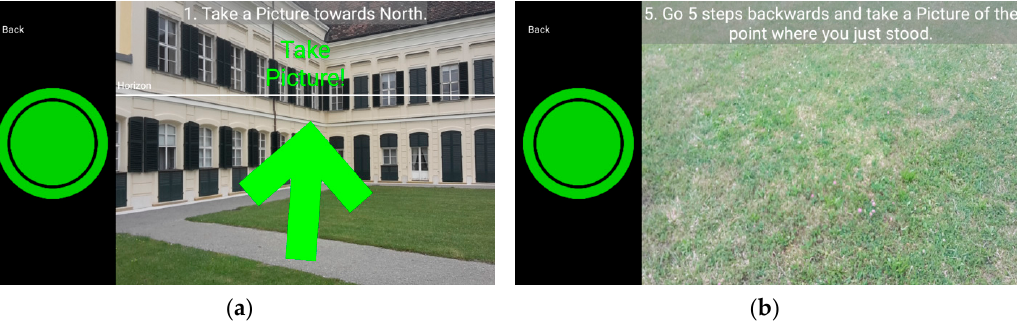
Figure 2. Screenshots from the FotoQuest Austria app showing: ( a ) Step 1, in which players are asked to take a picture in a northerly direction; and ( b ) Step 5, in which players take a picture of the actual point.